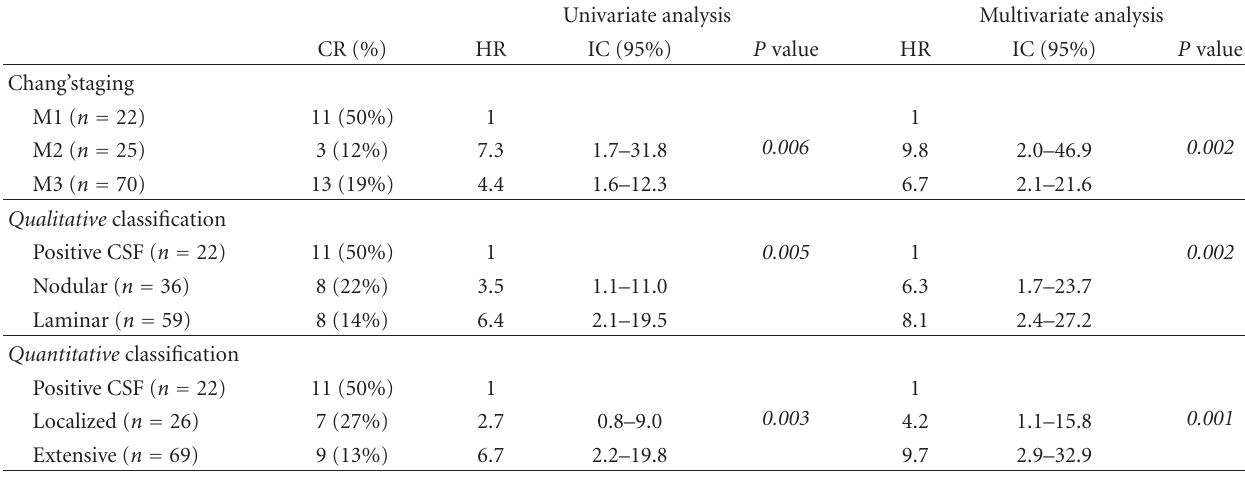
Table 2: Univariate and multivariate analysis of early Complete Response (CR) to sandwich chemotherapy.